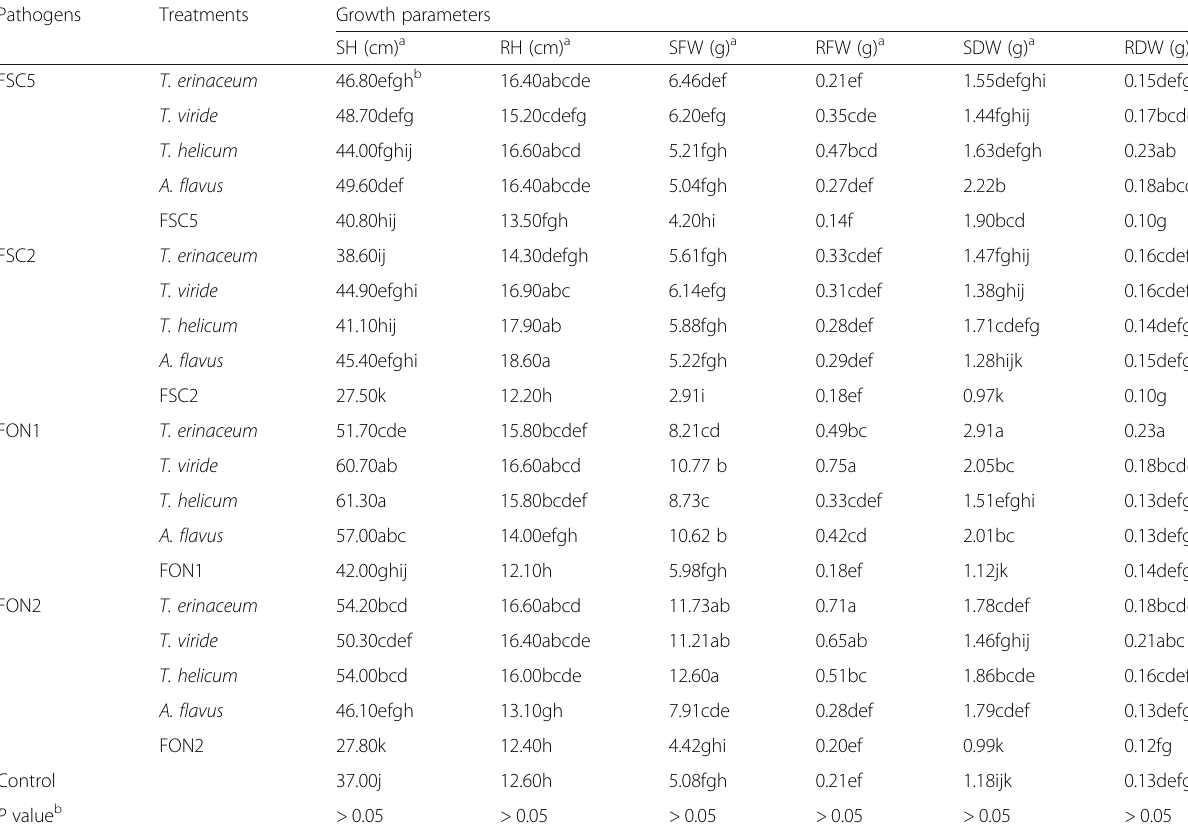
Table 9 Comparison of different growth parameter values: shoot and root heights (cm), shoot and root fresh weights (g), and shoot of root dry weights (g) recorded by watermelon seedlings inoculated by two F. solani f. sp. cucurbitae isolates (FSC 5 and FSC 2) and two F. oxysporum f. sp. niveum isolates (FON 1 and FON 2) and treated curatively by three Trichoderma spp. isolates and A. flavus Pathogens